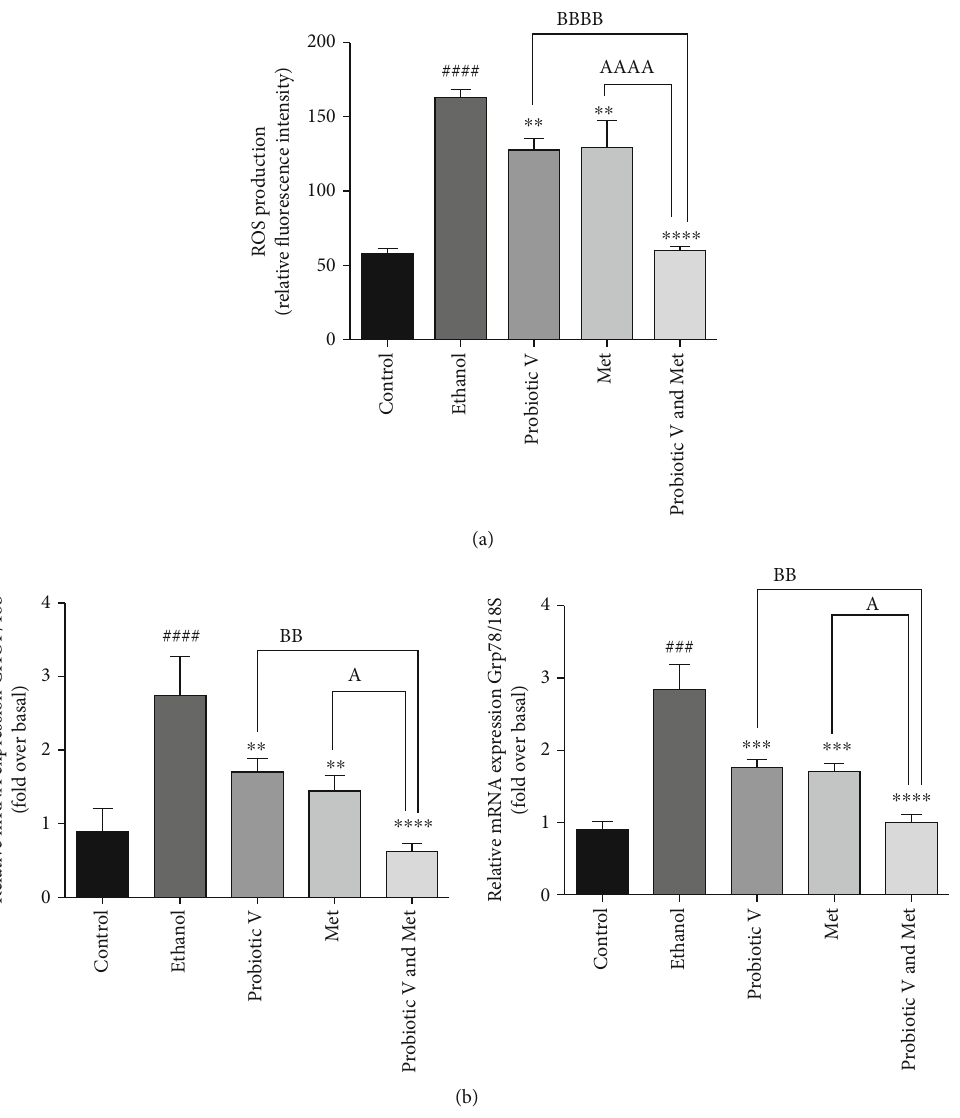
Figure 5: E ff ect of probiotic V and Met alone or together as probiotic V and Met combination on ROS production and ER stress upon the exposure to ethanol-exposed HepG2 cells by (a) fl uorescence spectroscopy with excitation/emission at 495nm/529 nm after incubation with carboxy-H -DCFDA and (b) mRNA expression of ER stress genes (CHOP and Grp78) in HepG2 cells. The gene expression levels were 2 calculated after stabilizing against 18S rRNA in every sample and are presented as relative mRNA expression units. Values represent the mean ± SD of three individual experiments. Statistical signi fi cance was assessed by one-way ANOVA followed by Tukey post hoc test. Statistical analysis: ### p < 0 : 001 and #### p < 0 : 0001 compared with control group; ∗∗ p < 0 : 01 , ∗∗∗ p < 0 : 001 , and ∗∗∗∗ p < 0 : 0001 compared with ethanol group; A p < 0 : 05 , BB p < 0 : 01 , and AAAA,BBBB p < 0 : 0001 compared with probiotic V and Met combinatorial